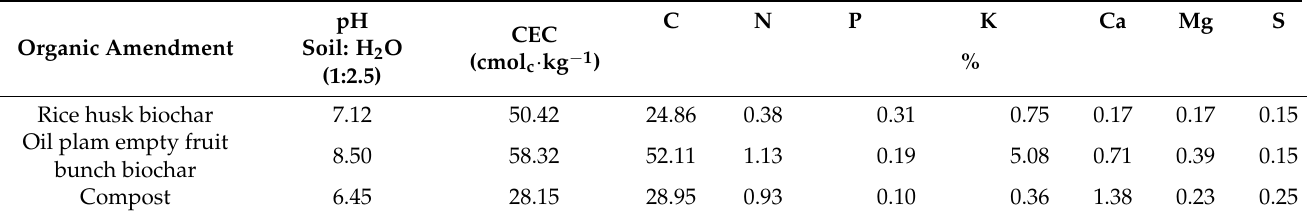
Table A2. Chemical characteristics of biochar and compost.